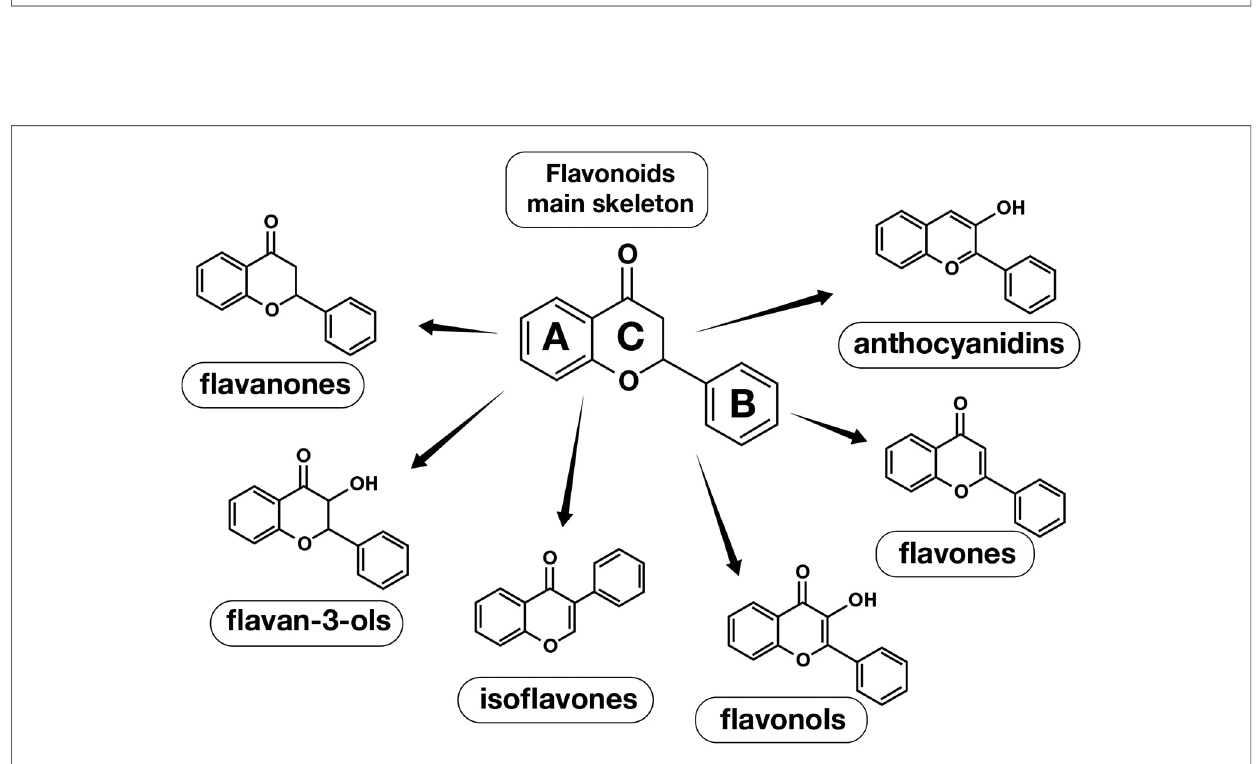
FIGURE 2 Allodynia and hyperalgesia vs. “ normal ” pain. Allodynia is the pain perception triggered by stimuli which under normal conditions are not painful. It is caused by a lowered pain threshold of nociceptors. Hyperalgesia is characterized by increased sensitivity to pain intensity triggered by normally painful stimuli.